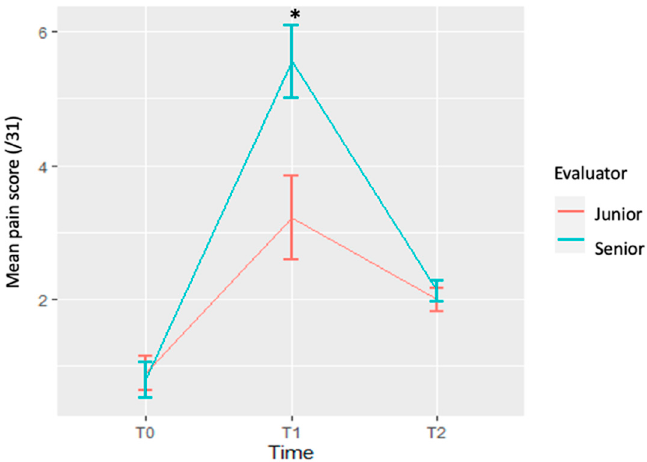
Figure 2. Comparison of pain scores assessed from a specialist (senior) and a veterinary student (junior). Data reported as the mean and SEM. * Significant difference between scores from senior and junior ( p ≤ 0.05).